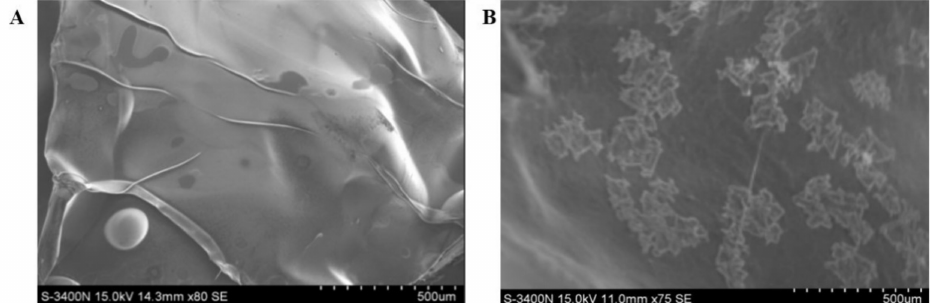
Figure 3. SEM images of bare scaffolds ( A ) and scaffolds combined with chitosan microspheres ( B ).